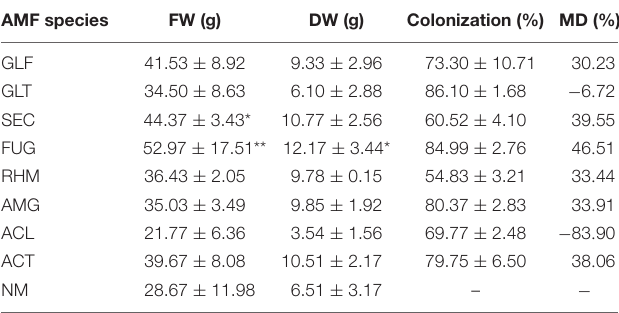
TABLE 1 | Effect of native AMFs inoculation on plant growth.